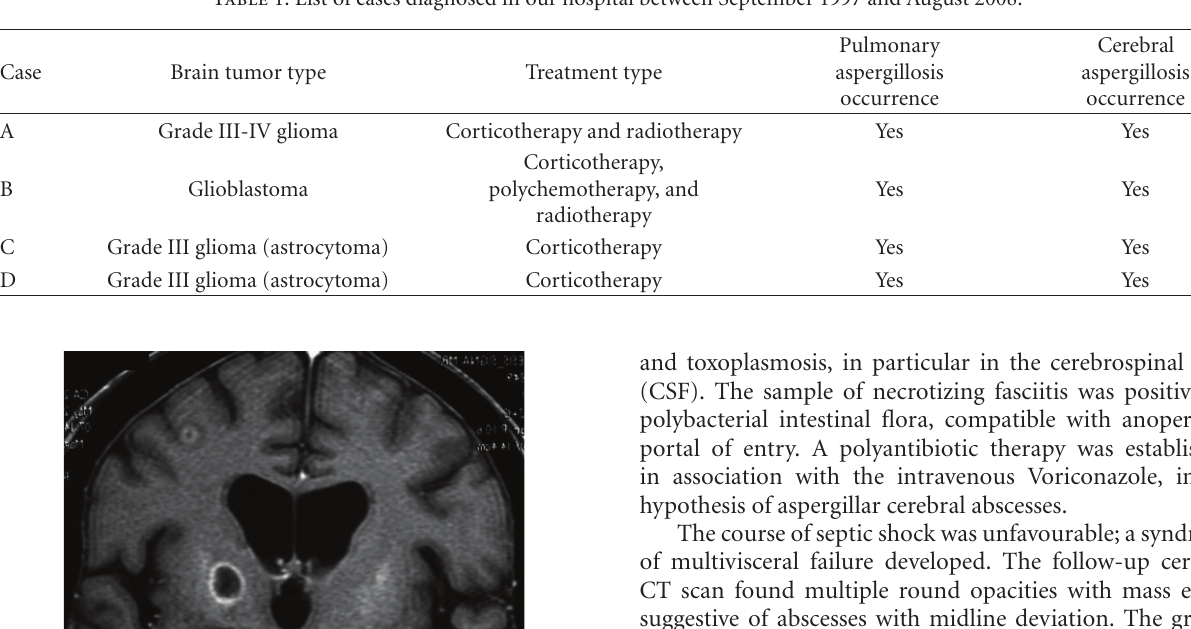
Table 1: List of cases diagnosed in our hospital between September 1997 and August 2008.